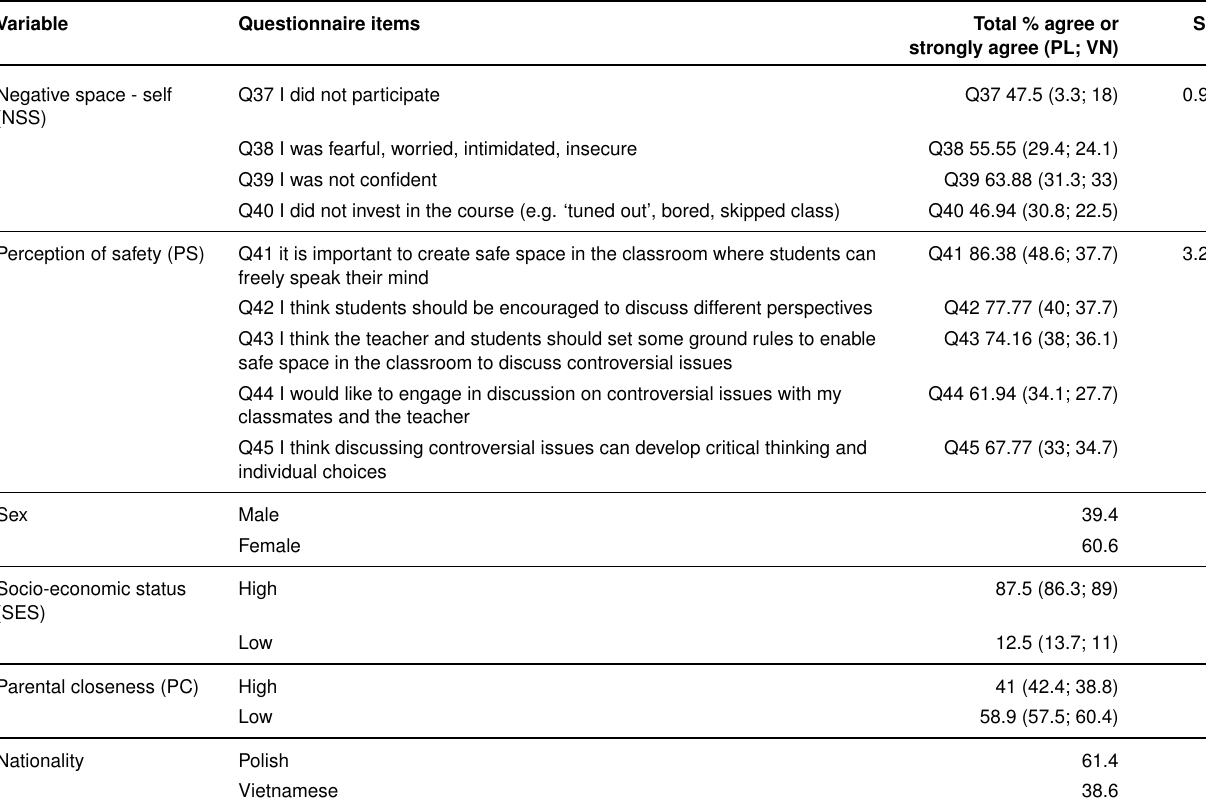
Table A1. (Continuation)